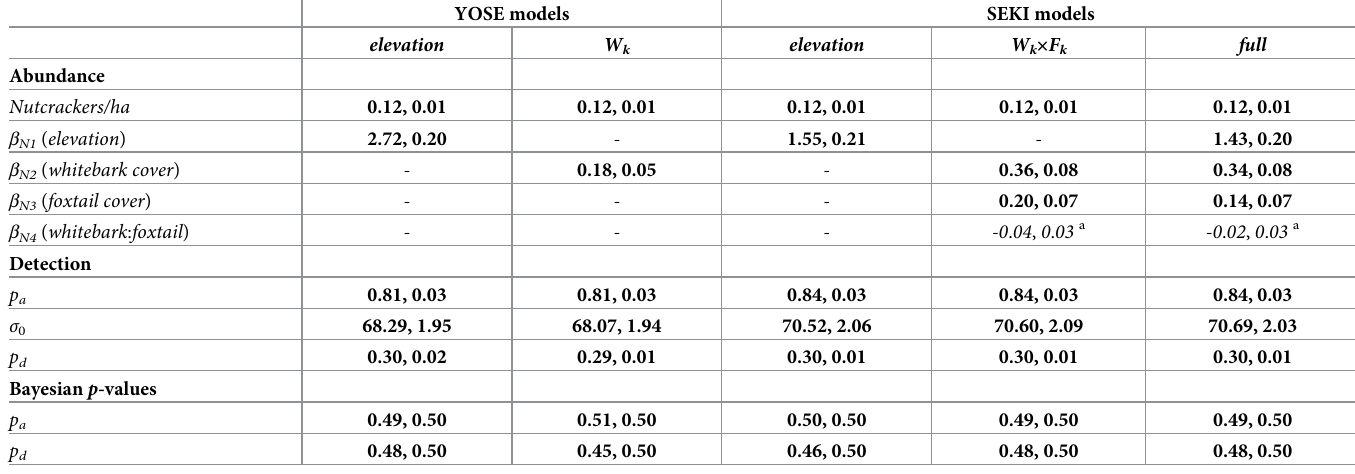
Table 5. Mean and standard deviation of parameter estimates and model diagnostics for spatial models of Clark’s nutcracker density in Yosemite National Park (YOSE) and Sequoia and Kings Canyon National Parks